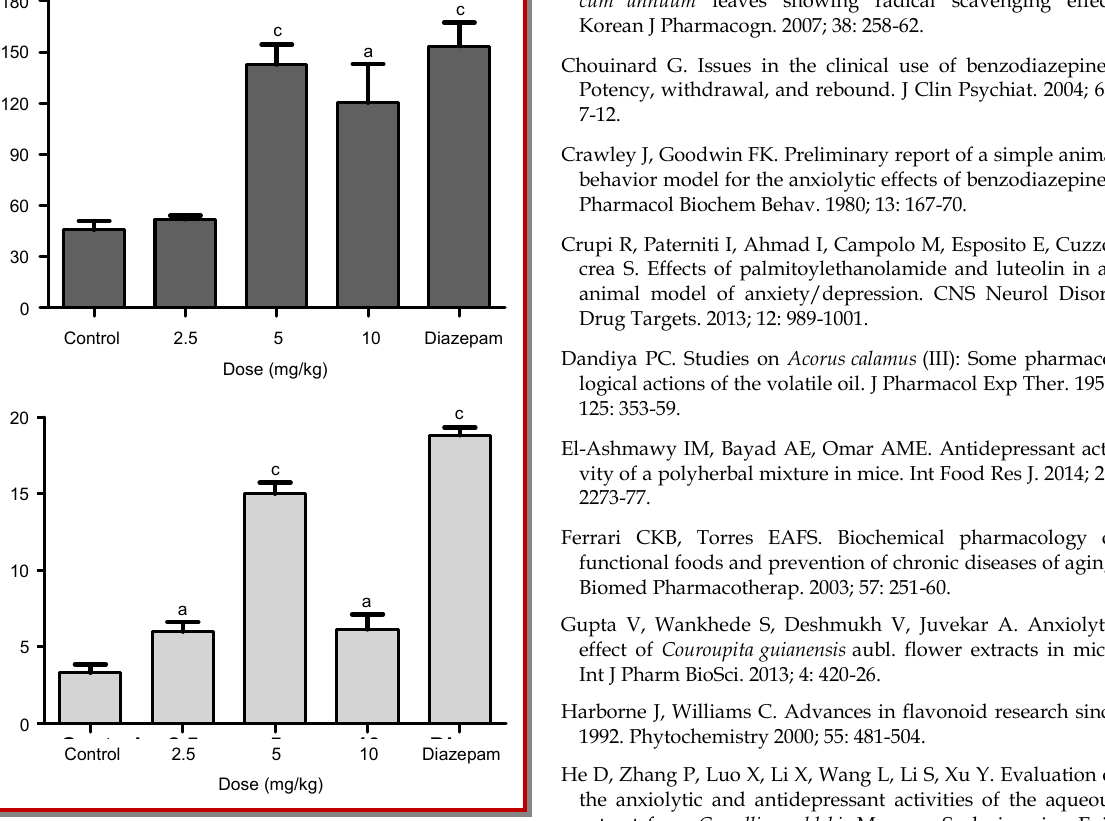
Figure 5: Effect of n -hexane fraction of C. annum at test doses in thiopental induced sleep in mice. Onset time of sleep (A), dura- tion of sleep (B). Control (Saline and Tween 80 2.5%), 2.5,5,10 mg/kg ( n -hexane fraction of C. annum ), and diazepam 1 mg. All values are expressed as mean ± SEM; n = 6; a p<0.05, b p<0.01, c